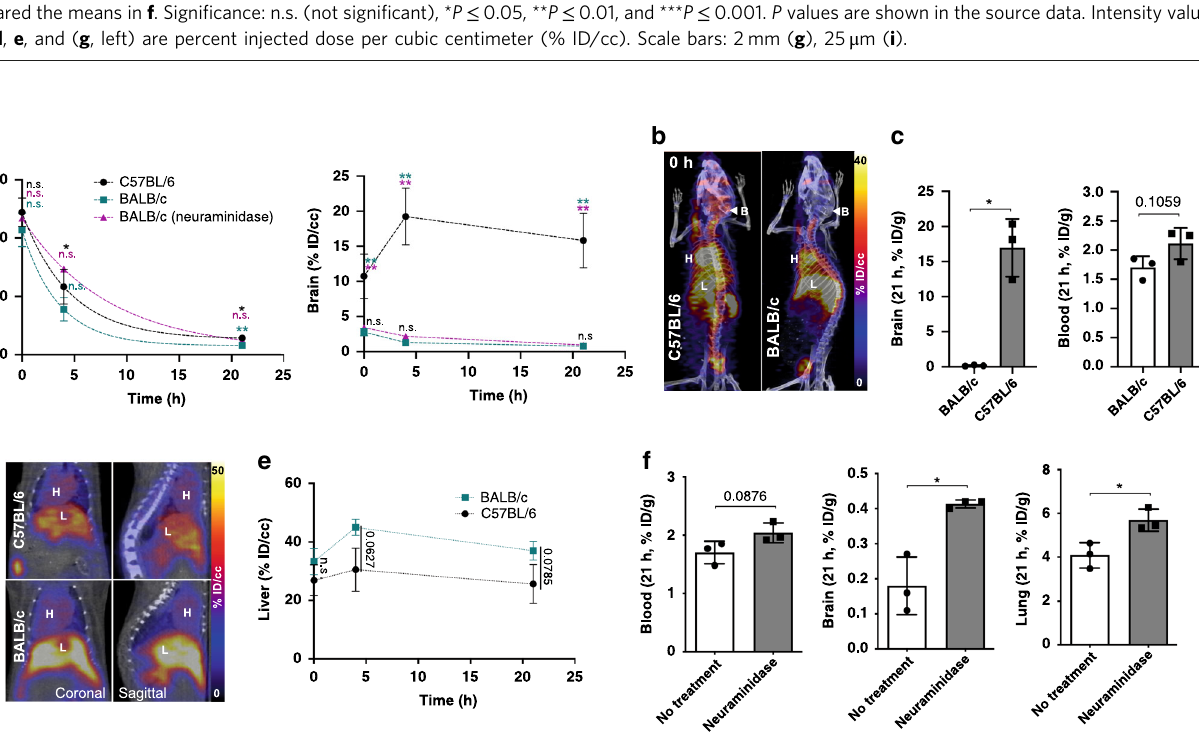
Fig. 3 PET and optical imaging-based assessment of AAV pharmacokinetics in C57BL/6 mice. a Experimental setup for region of interest (ROI) analysis (0, 4, and 21 h) and biodistribution (21 h) of 64 Cu-PHP.eB, -AAV9, and -AAV9-TC. PET images are acquired at 0, 4 and 21 h after AAV tail vein administration. b Projected PET/CT images at 4 (left) and 21 h (right) (H heart, L liver, S spleen, B brain). c Time activity curves (over 21 h) and d maximum brain uptake (at 4 h) of 64 Cu-PHP.eB (magenta triangle), 64 Cu-AAV9 (black circle), and 64 Cu-AAV9-TC (turquoise square) from the ROI analysis of blood and brain ( n = 3) after tail vein administration. e Representative projected PET/CT image at 4 h of 64 Cu-PHP.eB within the brain (B brain, JV jugular vein). f PK (left) and 21-h biodistribution (right) of PHP.eB ( n = 3, black circle) and (NOTA) 8 -A555-PHP.eB ( n = 4, black squares) obtained by qPCR. g Sliced PET/CT, autoradiography and GFP images of sagittal section of mouse brain (CB cerebellum, M midbrain, Th thalamus, CC cerebral cortex, S striatum)